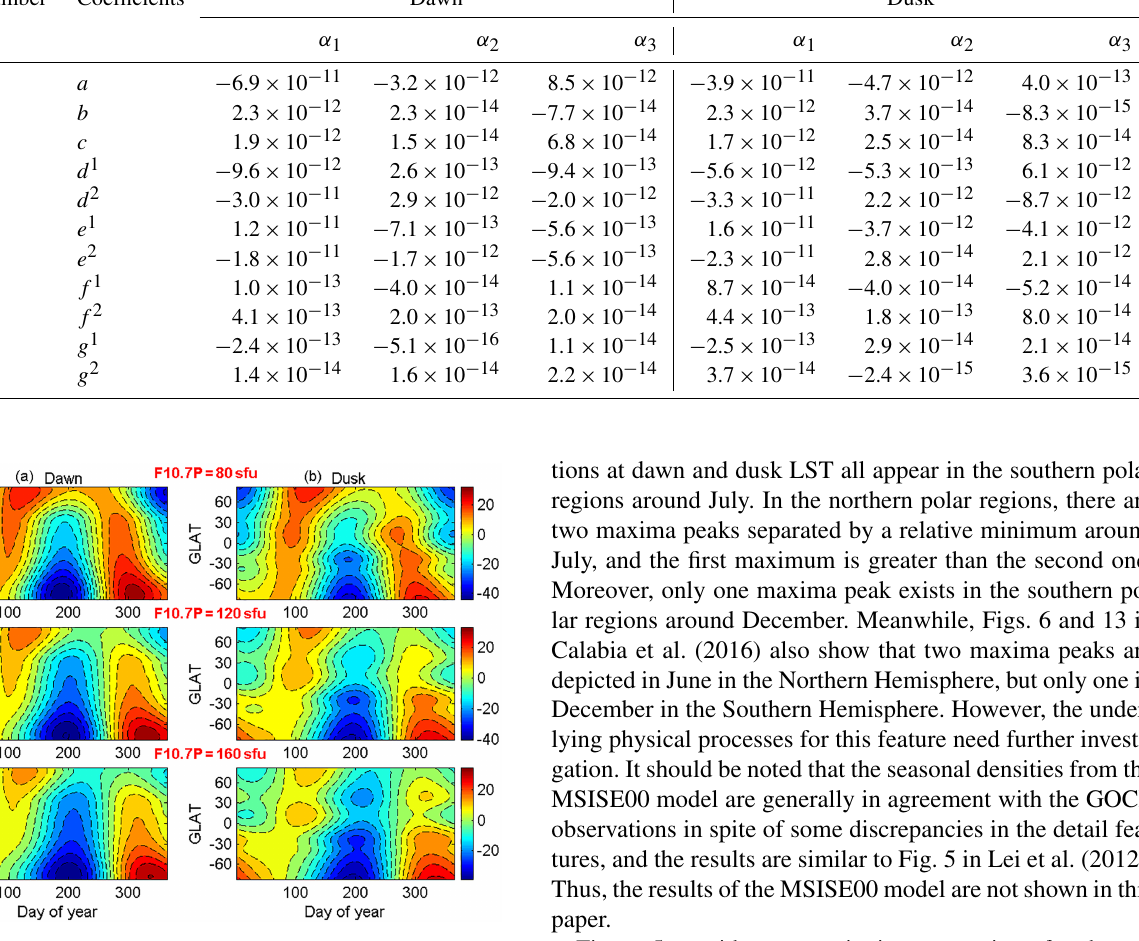
Figure 4. Relative seasonal variations to its annual mean in units of percentage at dawn (a) and dusk LST (b) under different solar activity